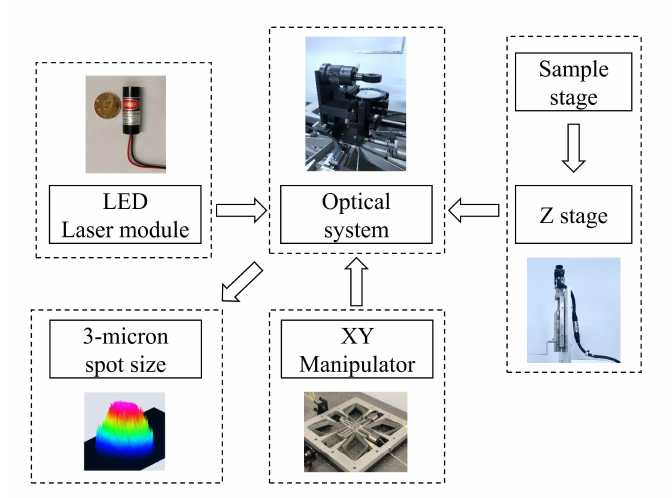
Figure 4. A schematic of an MSL